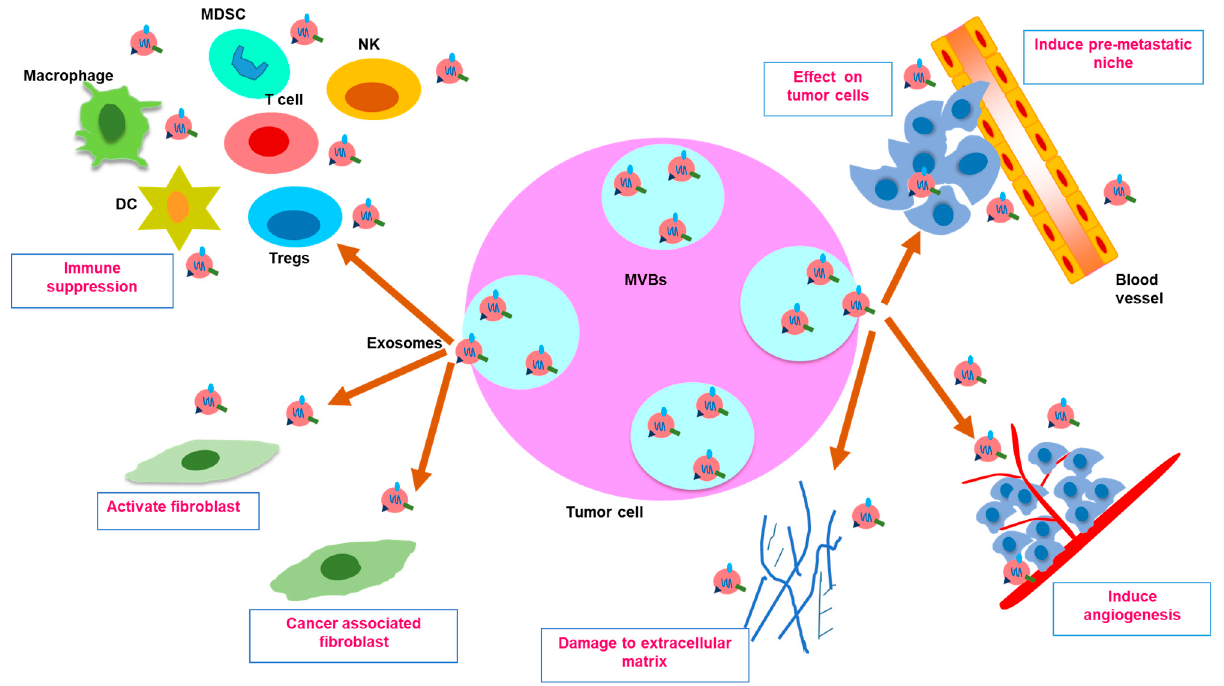
Figure 3. Exosomes in tumor microenvironment. Exosomes secreted from tumor cells containing MVBs exhibited a dynamic signaling between tumor cells and the TME. Exosomes may lead to immune suppression by downregulating macrophages, DC, T cells and NK cells and upregulating immunosuppressive cells like Tregs, MDSCs and TAMs. Exosomes induced differentiation of fibroblasts, activation of CAFs and degradation of ECM, which are associated with TME construction. They are involved in the alteration of ECM, hypoxia-mediated angiogenesis and the formation of pre-metastatic niches that trigger the metastatic escape of tumor cells. Abbreviations: CAFs, cancer-associated fibroblasts; ECM, extracellular matrix; DCs, dendritic cells; MDSCs, myeloid-derived suppressor cells; NK cells, natural killer cells; TAMs, tumor-associated macrophages; TME, tumor microenvironment; Tregs, tumor regulatory cells.